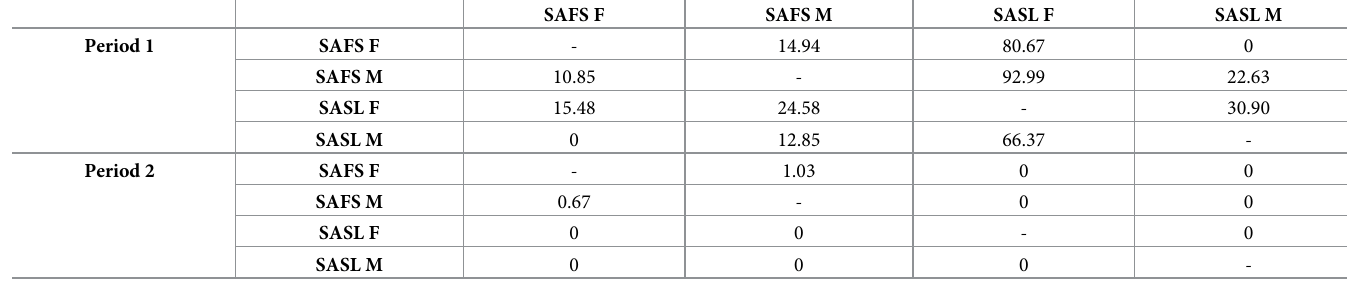
Table 4. Percent overlap between Peruvian otariid groups according to Period.